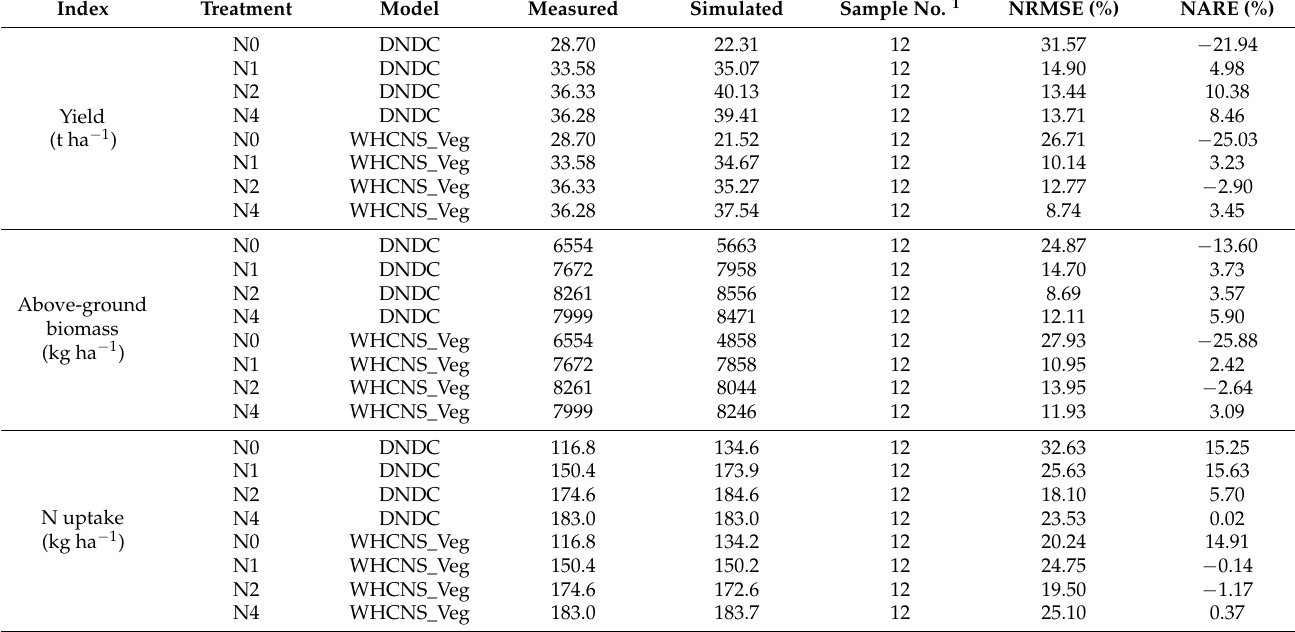
Table 4. Statistical validation between the simulated and measured potato tuber yield, above-ground biomass and nitrogen uptake using the DNDC and WHCNS_Veg models in Wuchuan,